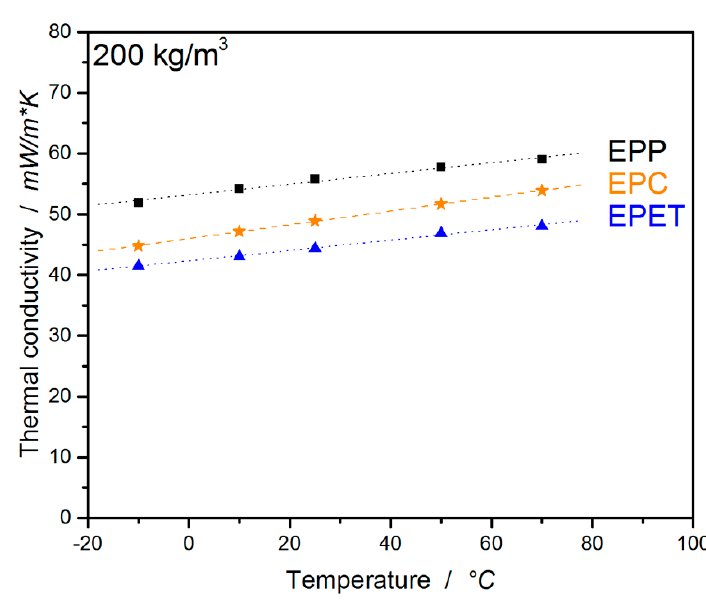
Figure 14. Temperature-dependent thermal conductivity of EPC, EPP, and EPET. Table 6. Full data for thermal conductivity investigation for EPC, EPP, and EPET.